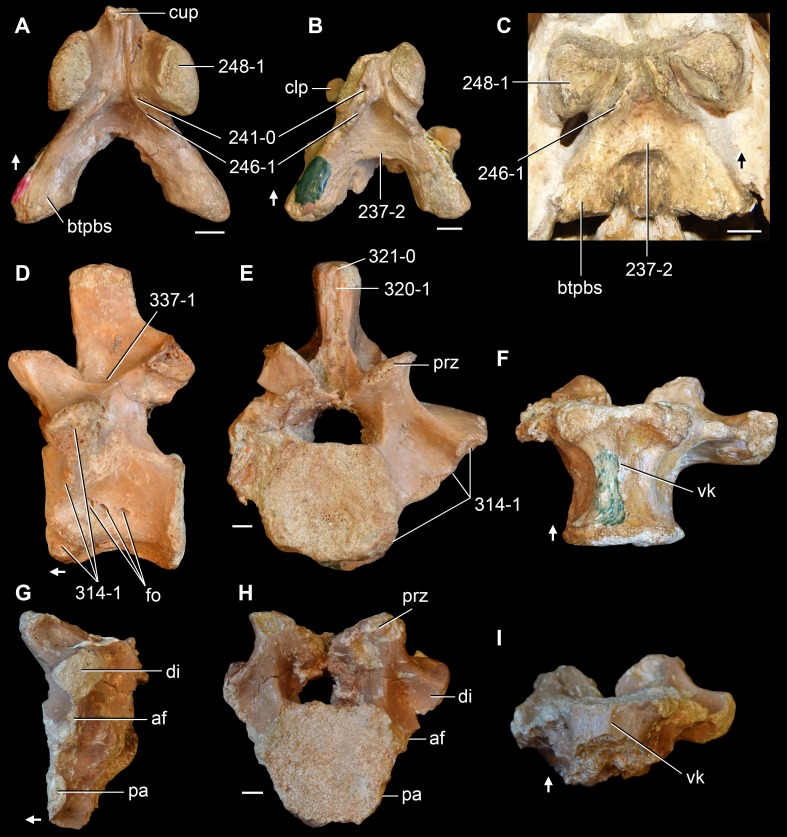
“Blomosuchus georgii” and Vonhuenia friedrichi.(A) holotype (PIN 1025/348) and (B) referred (PIN 1025/14) partial parabasisphenoids of “Blomosuchus georgii”; (C) parabasisphenoid of Proterosuchus alexanderi (NMQR 1484); and (D–F) holotype (PIN 1025/11) and (G–I) referred (PIN 1025/419, mirrored) cervico-dorsal vertebrae of Vonhuenia friedrichi in (A–C, F, I) ventral; (D) left lateral; (E, H) anterior; and right lateral (G) views. Numbers indicate character-states scored in the data matrix and the arrows indicate anterior direction. Abbreviations: af, accessory facet; btpbs, basal tubera of the parabasisphenoid; clp, clinoid process; cup, cultriform process; di, diapophysis; fo, foramina; pa, parapophysis; prz, prezygapophysis; vk, ventral keel. Scale bars equal 2 mm in (A, B, D–I) and 4 mm in (C).